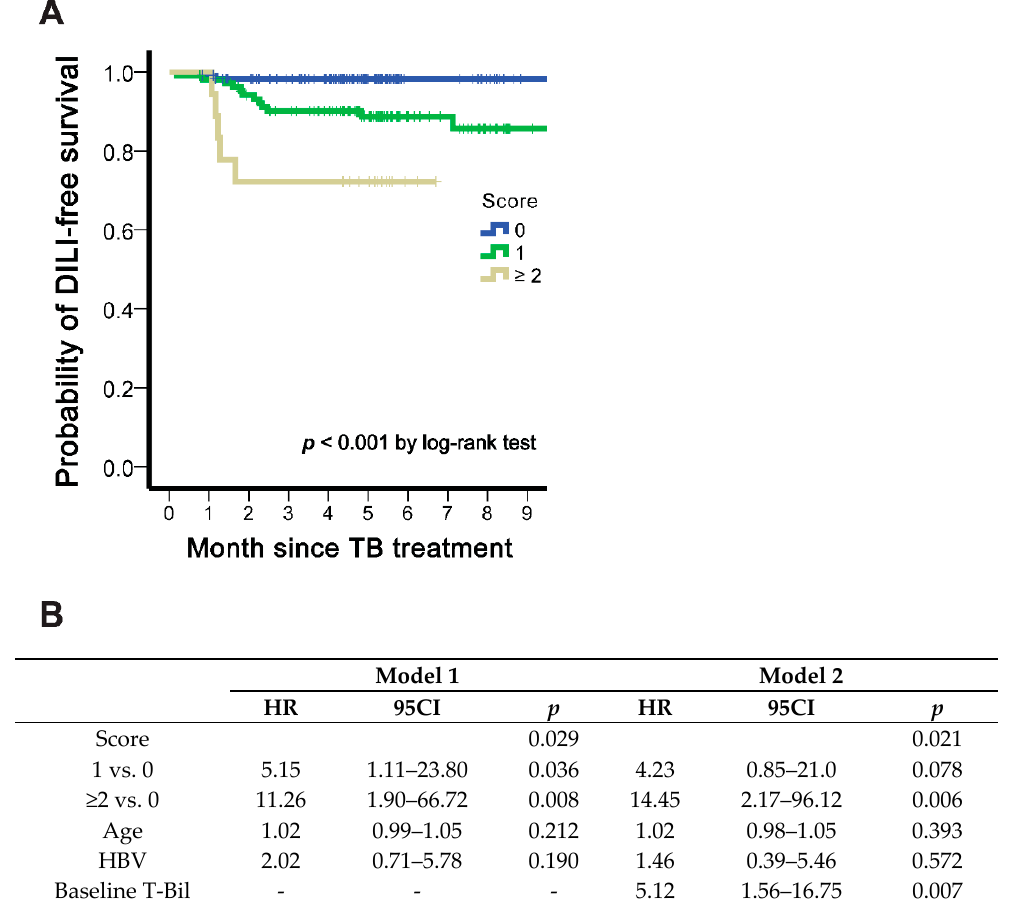
Figure 4. DILI-free survival in score stratification. ( A ) Kaplan Meier plot and ( B ) adjusted hazard ratios in cox regression analysis.